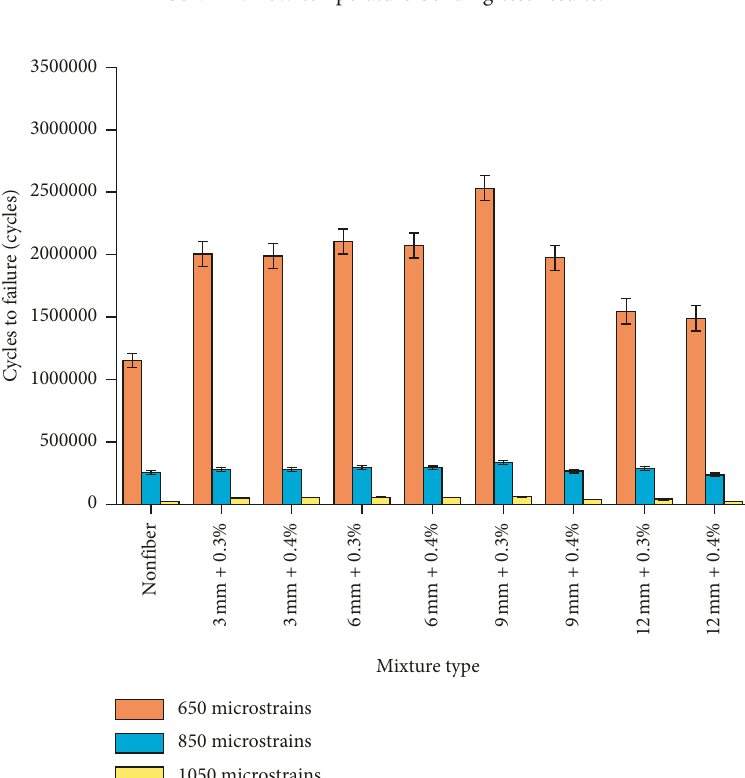
Figure 12: Four-point bending beam fatigue test